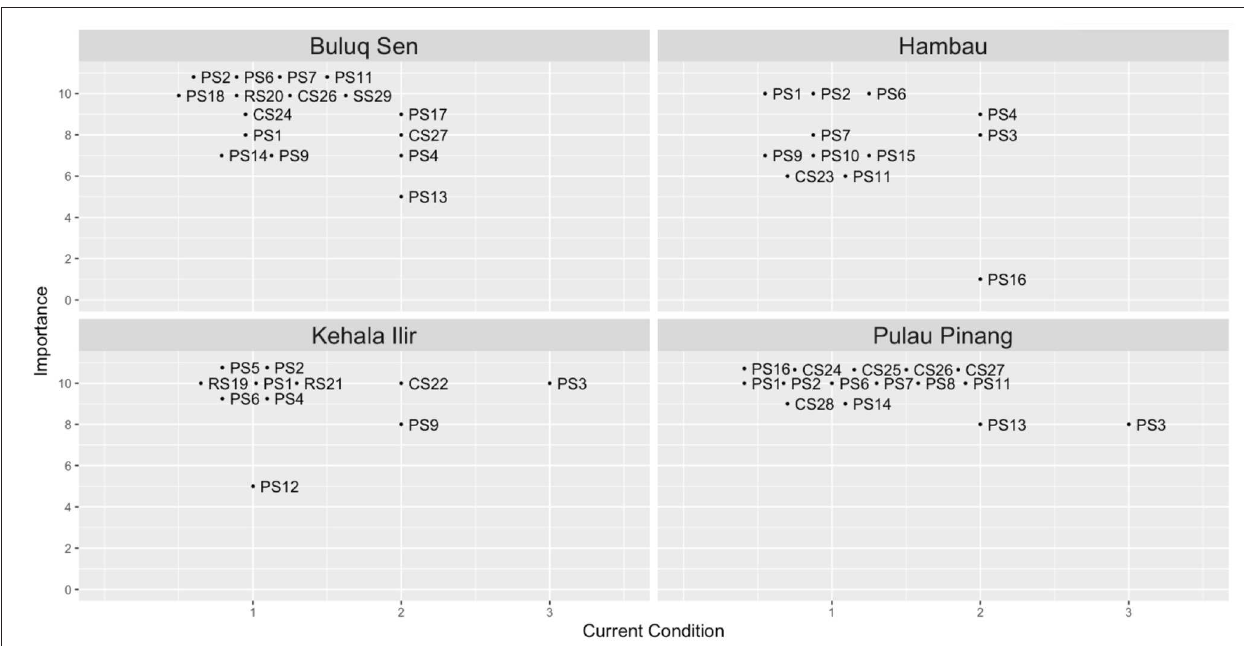
Frontiers in Forests and Global Change |